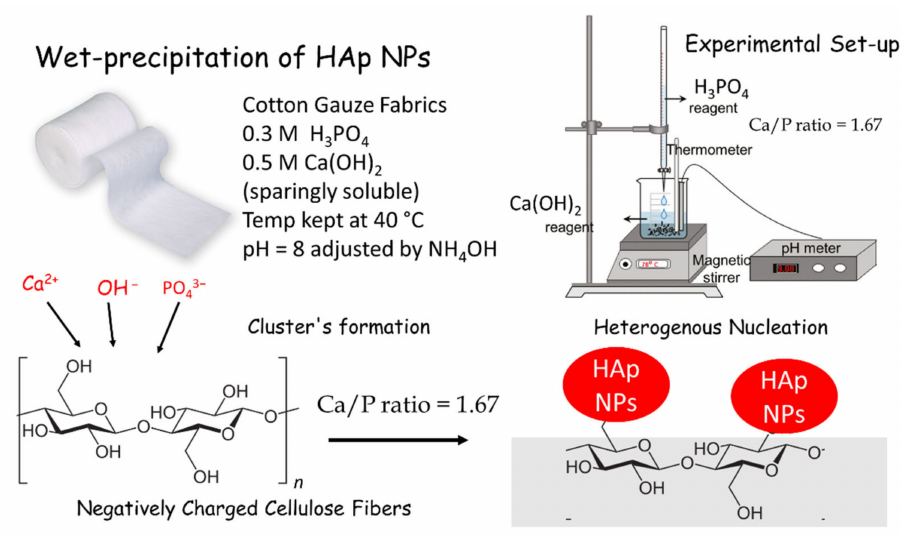
Figure 3. Schematic representation showing wet-precipitation of hydroxyapatite (HAp) and nanoparticles (NPs) on the surface of negatively charged cotton gauze fibers by primary adsorption or nucleation of the Ca 2+ /PO 43 − /OH − ions on the surface of cotton